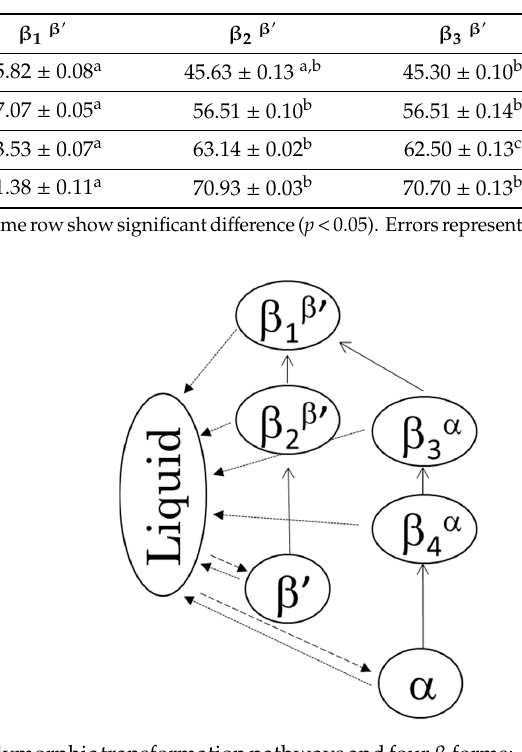
Figure 4. The two polymorphic transformation pathways and four β forms: crystallization (broken transformation (solid lines), and melting (dotted lines), transformation (solid lines), and melting (dotted lines).